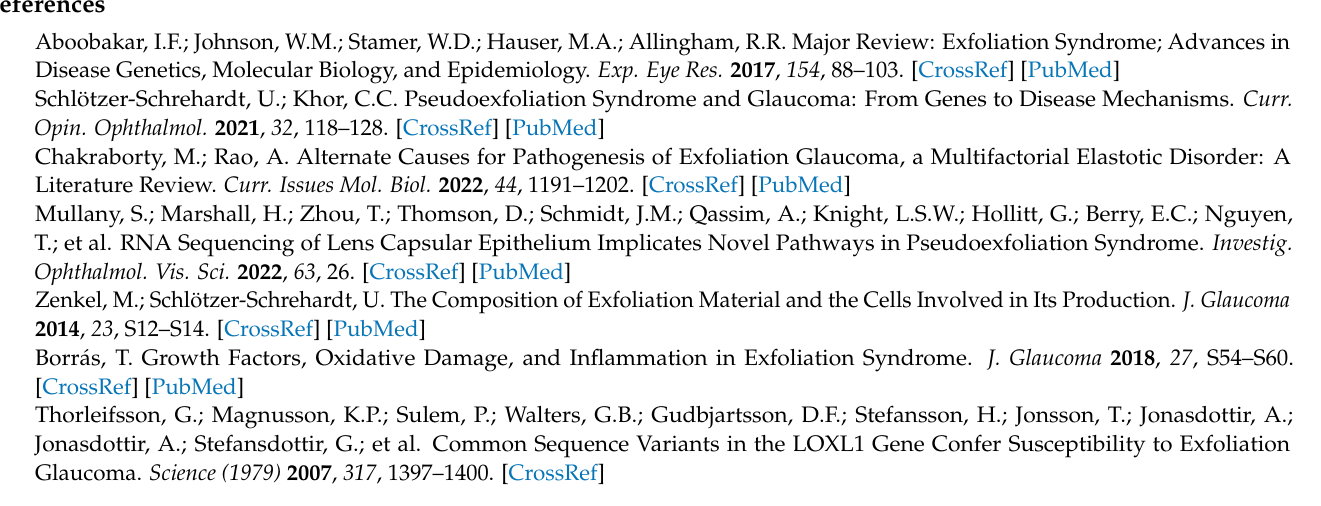
Table S1: RT-qPCR primer sequences; Table S2: Genelist resulting from RNA-Seq, sorted by adjusted p -value; Table S3: Enrichment